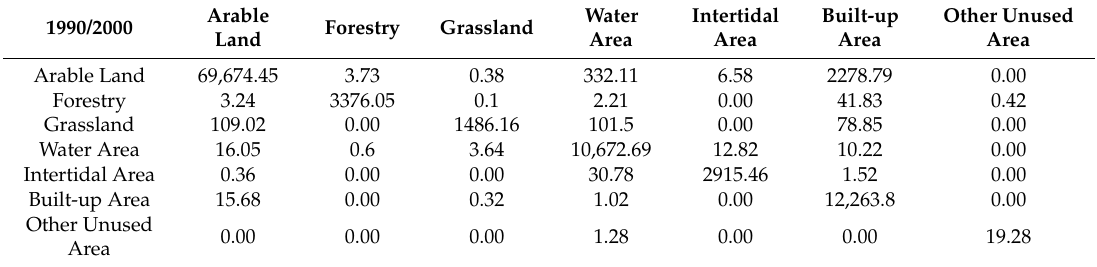
Table 3. Land use situation transition matrix in Jiangsu province from 1990 to 2000 (km 2 ).